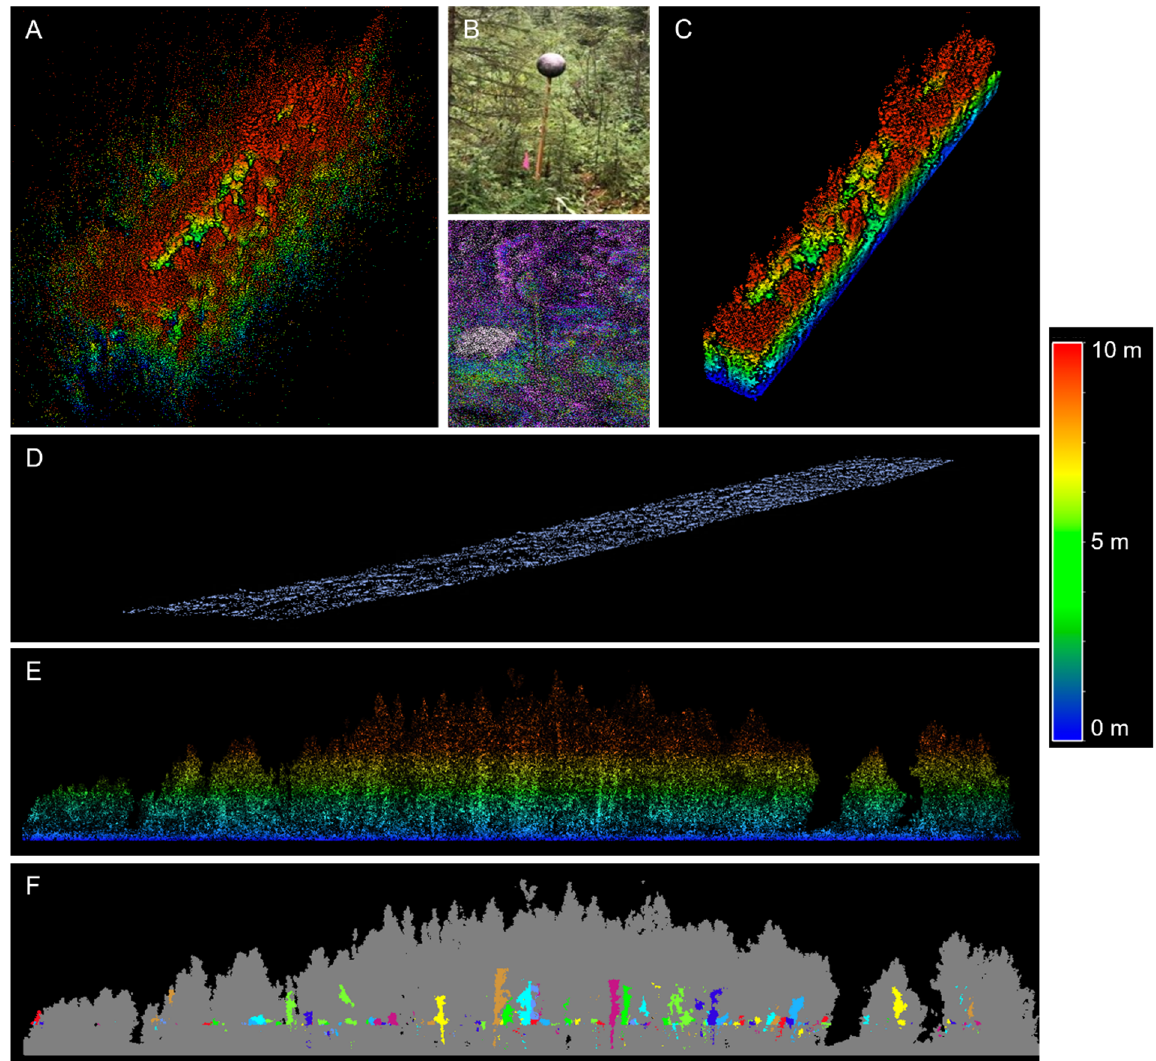
Figure 3. Visualizing of the data preprocessing in LiDAR 360. Specifically, ( A ) shows an entire point cloud of a sampled seismic line area following outlier removal; ( B ) includes both a photo and a point cloud clip of a target placed on the seismic line area; ( C ) is a point cloud clipped to the 3 × 55 m area of interest; ( D ) shows an isolation of the identified ground layer points; ( E ) is a profile view of the clipped point cloud normalized based on the identified ground points; ( F ) is a profile view of the same seismic line area as E following point cloud segmentation, with individual trees represented by unique colours relative to their neighbours and noise points in grey.